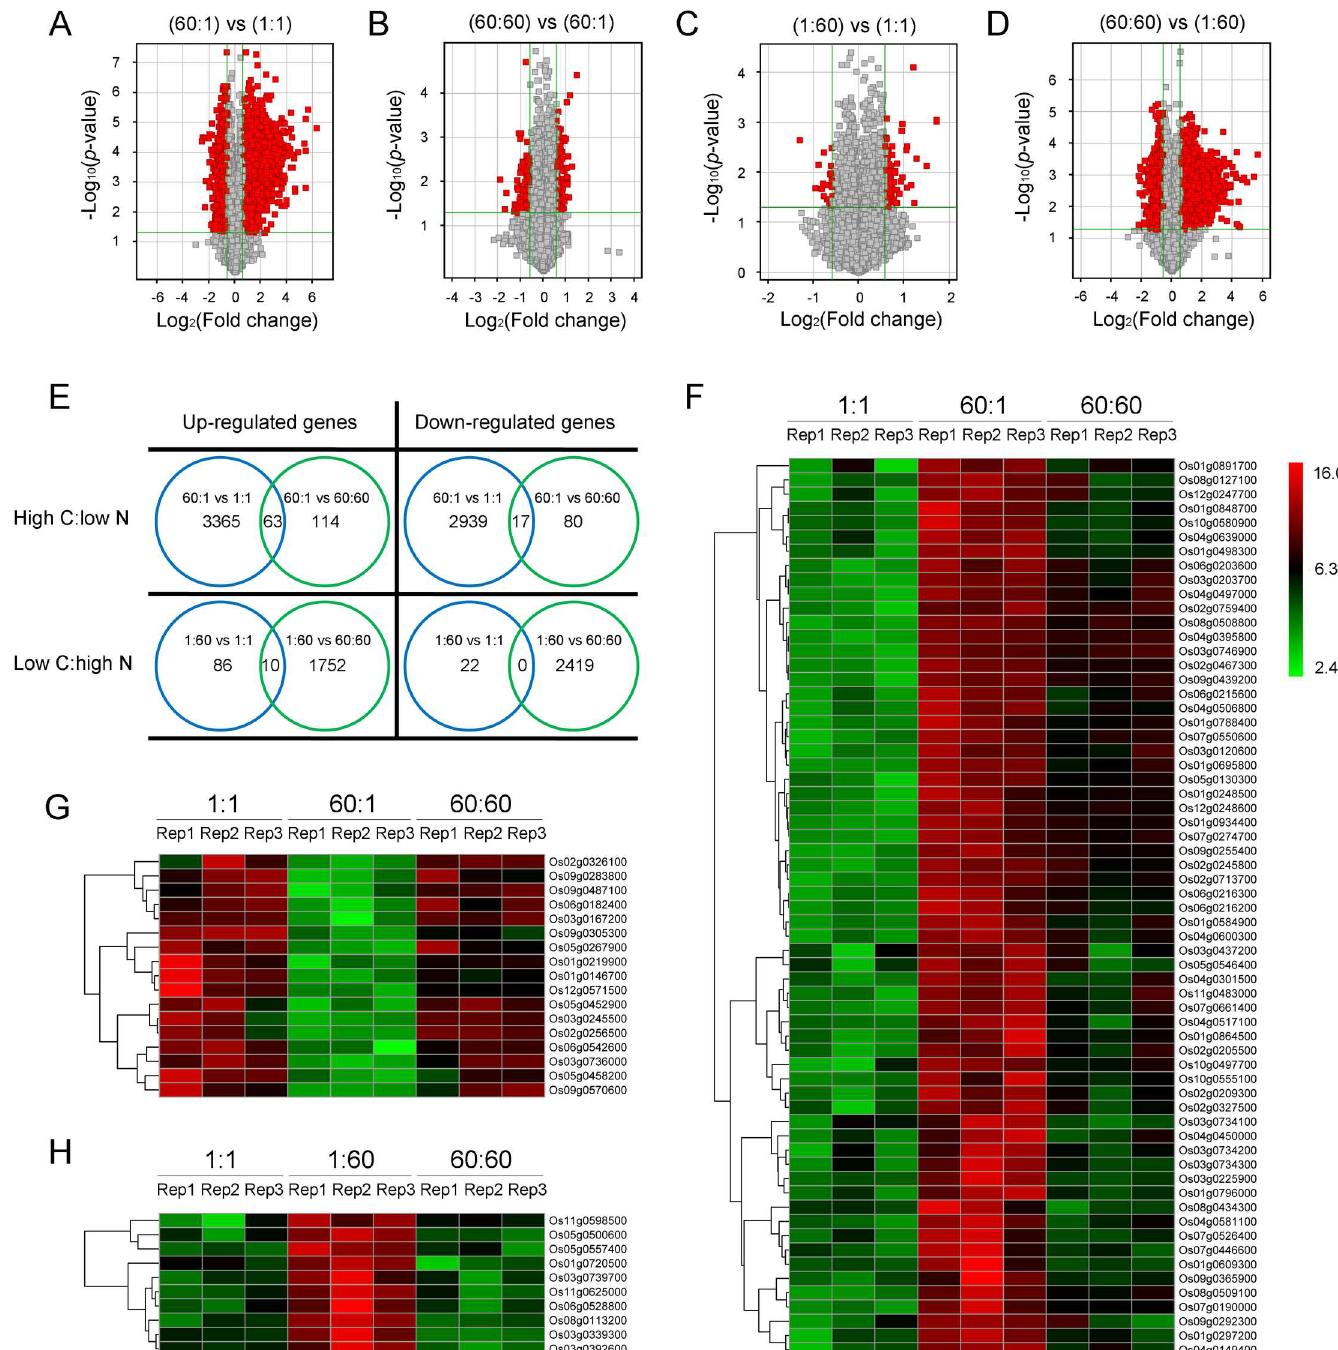
Fig 3. Identification of genes responsive to imbalanced high C:low N and low C:high N. (A-D) The Volcano Plots for differentially expressedgenes between treatments. The two vertical lines are the 1.5-fold changeboundariesand the horizontallines are the statistical significanceboundaries ( p < 0.05). Genes with fold change > 1.5and statistical significance are marked with red dots. A, 60:1 compared with 1:1; B, 60:60 compared with 60:1; C, 1:60 compared with 1:1; D, 60:60 comparedwith 1:60. (E) Venn diagram of rice genes (probe sets) responded to C:N treatments. (F-H) Hierarchicalcluster analysis of high C:low N and low C:high N responsivegenes. The log 2 ratio values of probe sets were used for the analysiswith R software. The colored bars represent the value (log 2 (fold change)) of the transcripts in each bin after C:N treatments. Green represents down-regulated probe sets, red represents up-regulated probe sets, and dark indicatesno significant difference in gene expression. F, High C:low N up-regulated genes; G, High C:low N down-regulated genes; H, Low C:high N up-regulated genes. “vs” represents “comparedwith”.